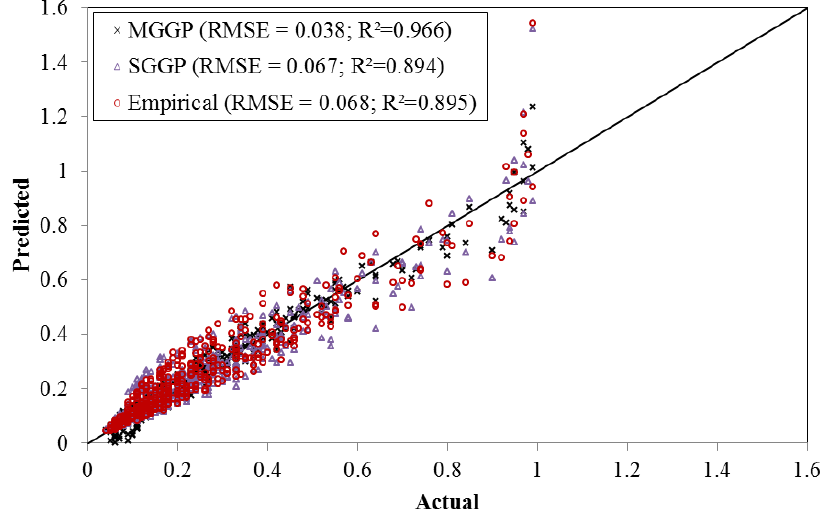
Figure 9. Comparison of the evolutionary and empirical predictions.